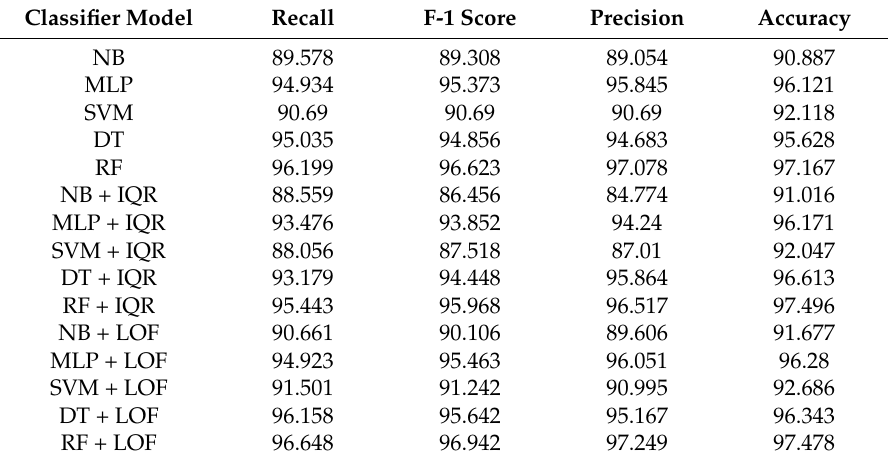
Table 8. Classification model performances.